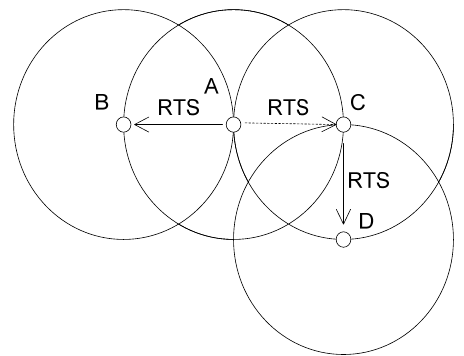
Figure 4. The idea of Parallel transmission using four